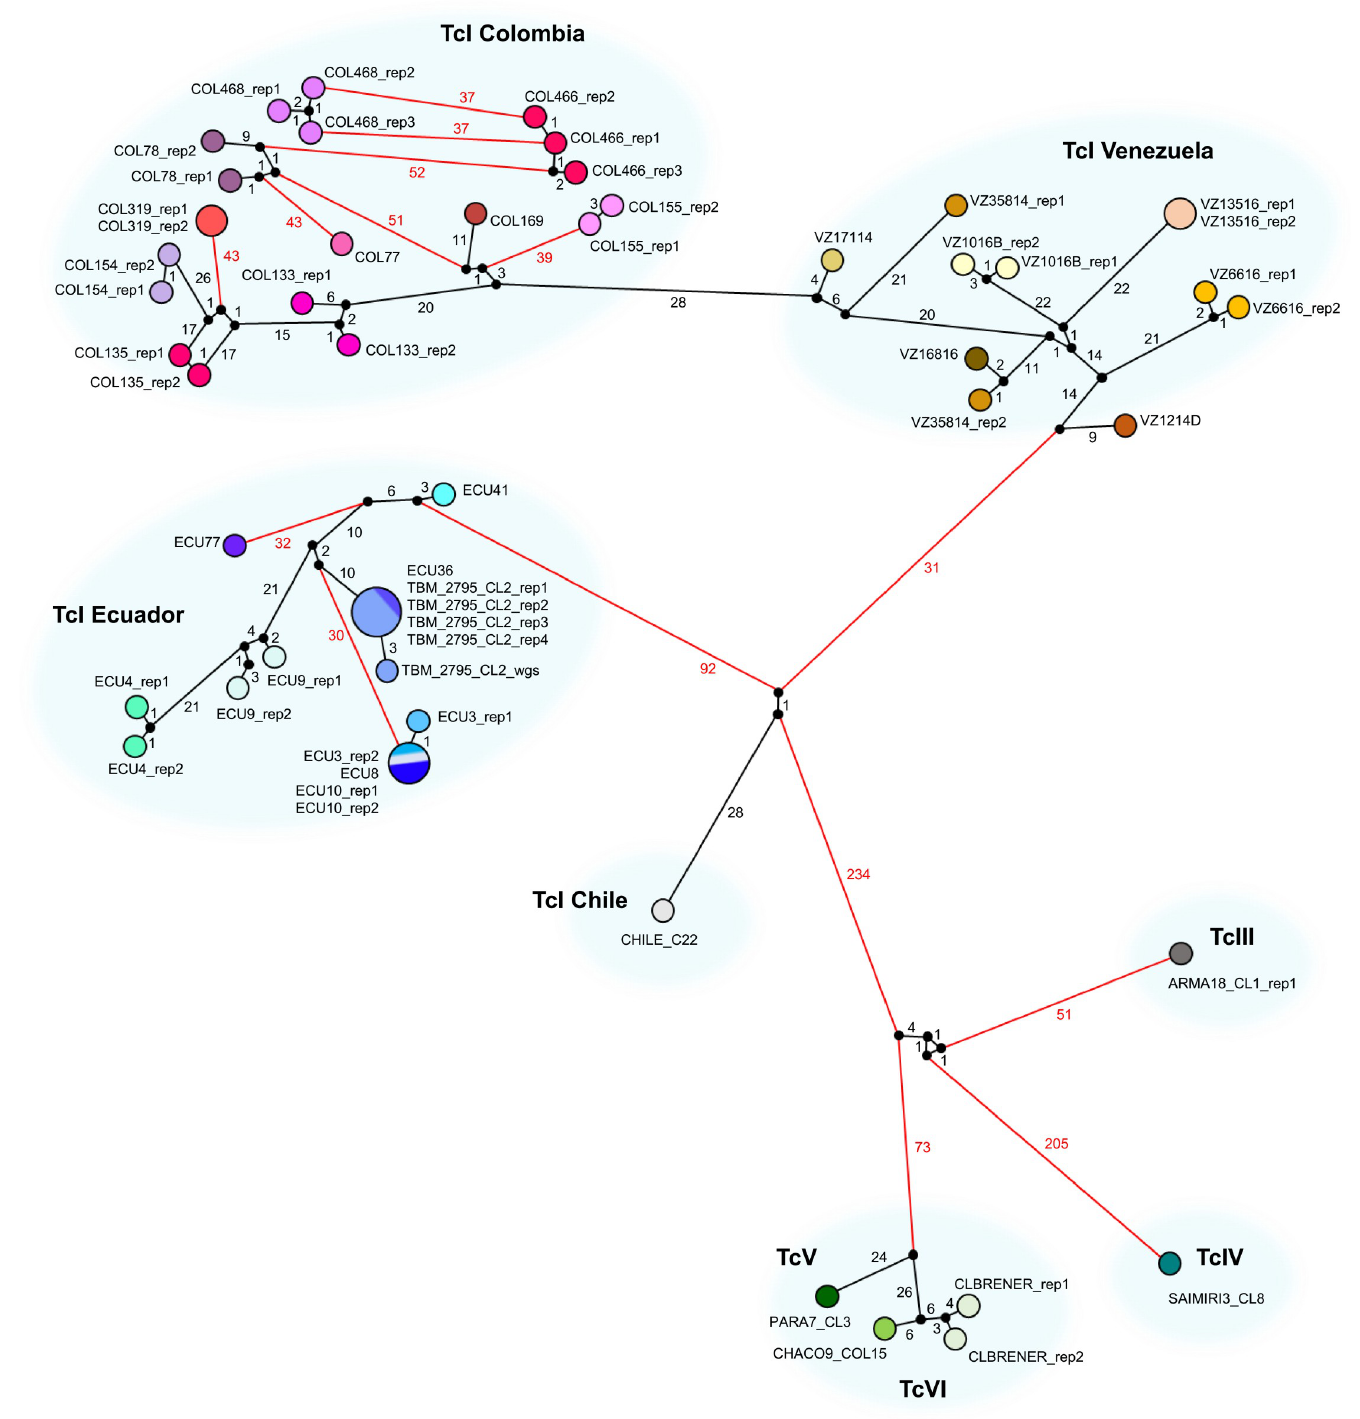
Fig 4. Allelic Differences among T . cruzi I samples and reference clones of other DTUs as a median-joining network. A single SNP locus can differ by 0, 1 or 2 between two individuals (i.e., the individuals match at both, one or neither allele). The AD measurement indicated on each edge of the network represents the total number of differences across all loci for which genotypes were called in all individuals of the dataset (n = 561). Red edges indicate differences of 30 and above. Technical replicates are represented by circles of the same fill color. Larger circles represent the occurrence of identical GLST genotypes. Edge length is not directly proportional to